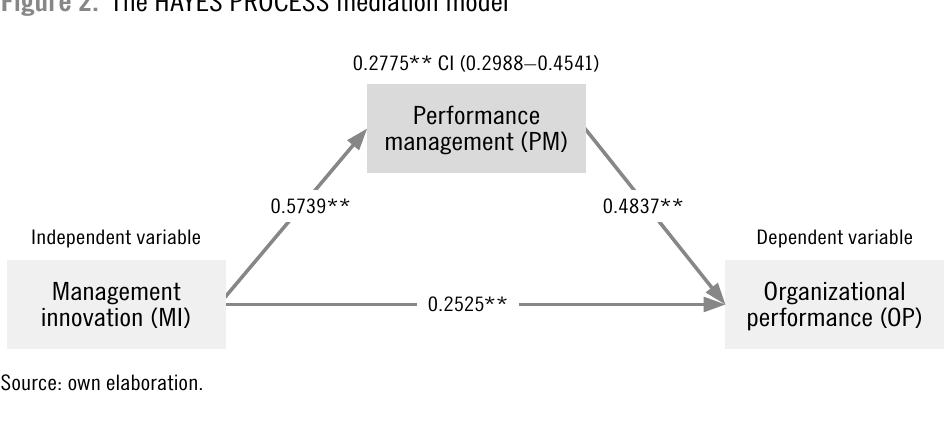
Figure 2. The HAYES PROCESS mediation model